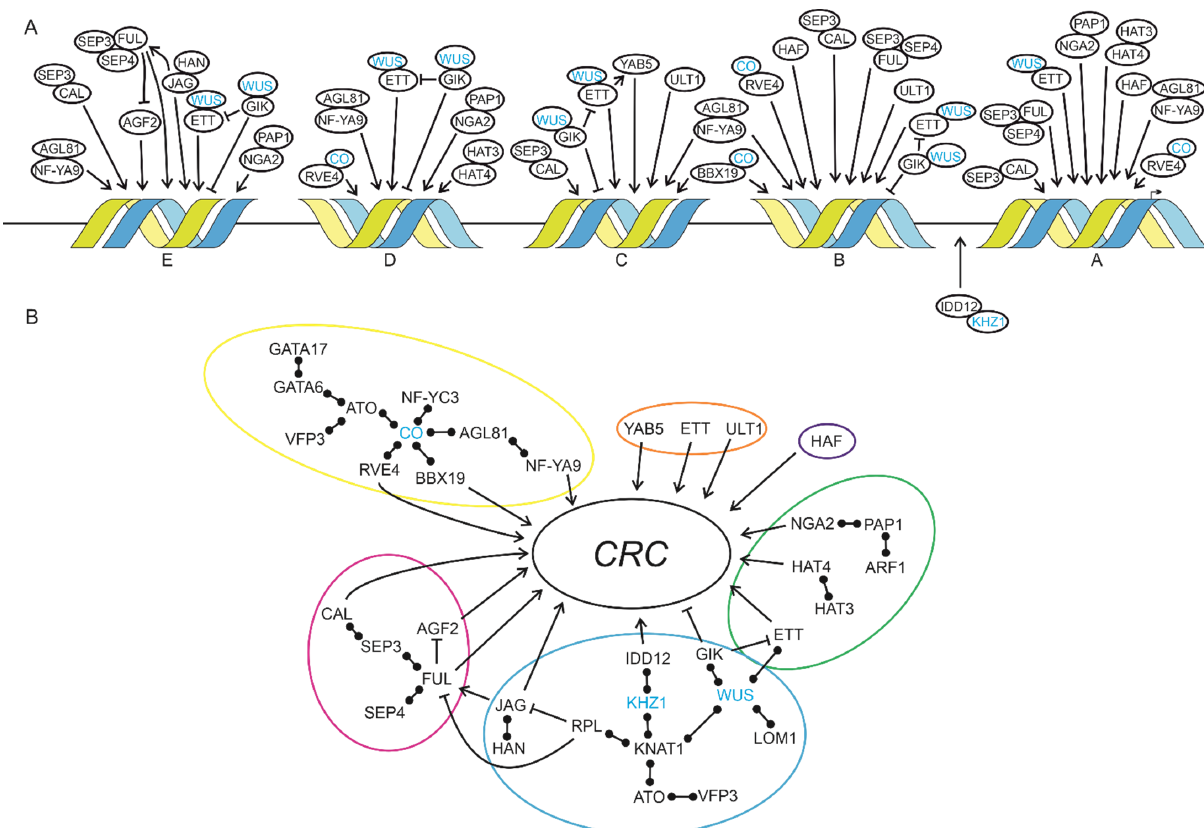
Figure 4. Networks regulating CRC expression. ( A ) Localization and binding of CRC regulators based on Y1H and qRT-PCR results and [65]. Regulators were assigned to the conserved regions of proCRC (A–E) accordingly to the Y1H screen and in silico prediction analyses. Proteins without an arrow were not tested via qRT-PCR but interact with proteins identified in this study based on BioGRID searches [3]. Protein–protein interactions are symbolized by overlapping circles and proteins in blue were not present in the Y1H results, but link identified regulators to each other. Protein interactions are shown by overlapping circles, transcriptional activation and repression are symbolized by pointed or blunt-end arrows, respectively. ( B ) Contribution of flower-related processes to CRC expression. Colored circles indicate cofunctional networks with flowering induction in yellow, ab-/adaxial regulation in orange, carpel structures in dark blue, auxin response in green, meristem regulation in light blue, and flower development in purple. Protein interactions are shown by bars with two circles, transcriptional activation and repression are symbolized by pointed or blunt-end arrows, respectively.